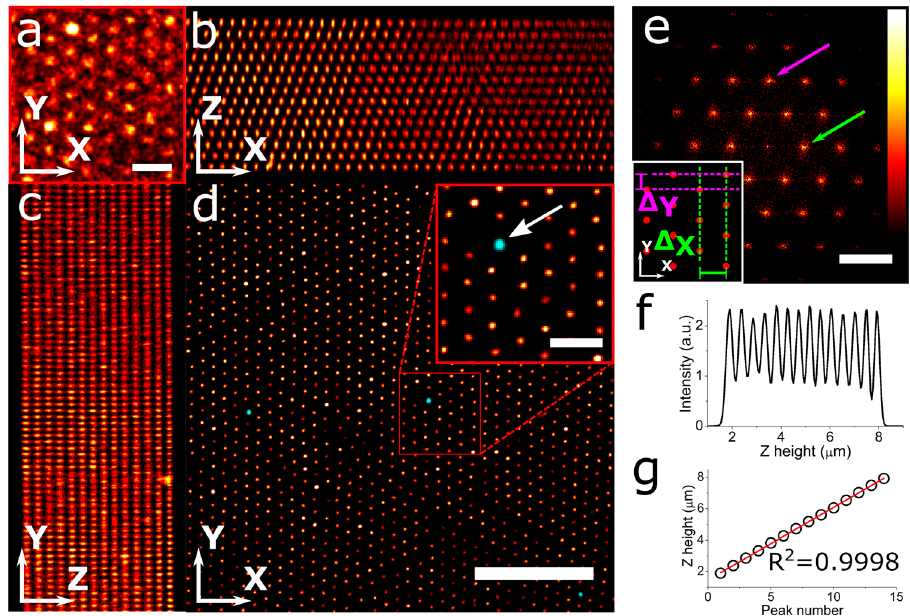
Fig. 2 Calibration of confocal microscope. a Close-up of a slice 3.6 μ m from the cover glass from a confocal stack of the colloidal crystal (1 pixel Gaussian blur) acquired using a Leica HC PL APO 93×/1.30 GLYC motCORR STED WHITE objective and a pinhole of 0.7 Airy units. The scale bar is 1 μ m. b Average projection of the XZ planes of the confocal Z -stack after deconvolution, showing the ABC stacking in the (110) plane of the FCC crystal. c Average projection of the YZ planes of the deconvolved confocal Z -stack, showing the (112) plane of the FCC crystal. d Overlay of an XY slice of the confocal stack of both re fl ection (cyan) and deconvolved fl uorescence (red) 3 μ m from the cover glass. The arrow points at a gold core bead imaged in re fl ection mode. The scale bars are 5 and 1 (inset) μ m. e Fast Fourier transform of ( d ) demonstrating long-range hexagonal order. The arrows point to the peaks in the FFT image used for calibrating distances in the X (green) and Y (magenta) directions. The scale bar is 3 μ m − 1 . The inset shows the characteristic distances Δ X (green) and Δ Y (magenta) in the real-space crystal corresponding to the peaks in the FFT image. f Intensity pro fi le in the z -direction, demonstrating the periodicity in the axial direction. g Linear fi t of the peak positions in ( f